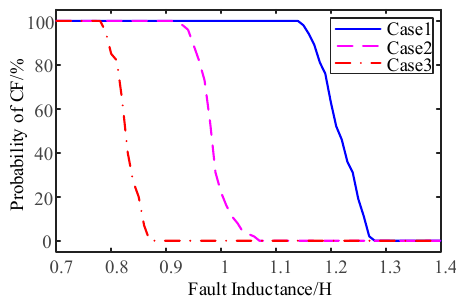
Figure 8. The probability of commutation failure (CF) in different cases under three phase fault. In order to indicate the severity of the three phases to ground fault, the minimum AC voltage RMS values at the LCC inverter side (without a SC) during the fault period, at different fault inductances, are summarized in Table 3. Table 3. The minimum AC voltage RMS values during the three phase to ground fault periods. Fault Inductance/H